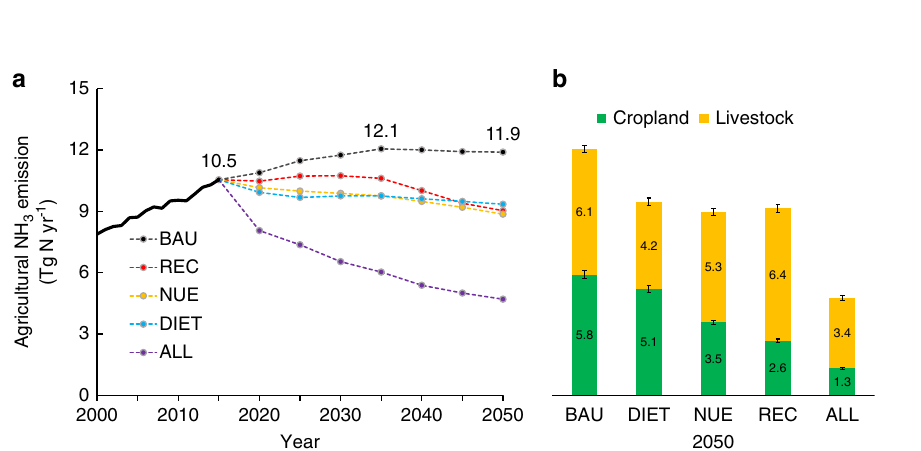
Fig. 2 Agricultural NH 3 emissions under different scenarios in 2050. Agricultural NH 3 emissions by different scenarios ( a ) and source contribution ( b ) in 2050. BAU refer to business as usual scenario; REC represents the scenario of manure recycling to cropland; NUE is the scenario of improving N use ef fi ciency both in cropland and livestock production systems; DIET is the scenario of optimizing human dietary structure; ALL scenario is the combination of all NH 3 mitigation measures in REC, NUE and DIET scenario, the error bars denote the 95% con fi dence intervals of the speci fi c emissions. Source data are provided as a Source Data fi